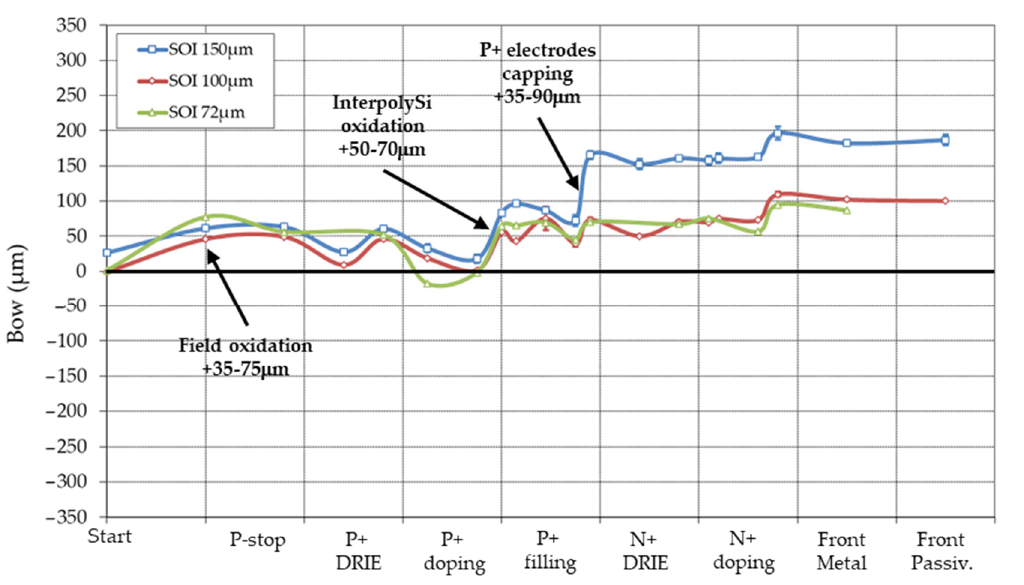
Figure 16. Bow variation during process of SOI wafers of various silicon device thicknesses. Handle wafer: 300 μ m, BOX: 1 μ m. Main stress contributors are indicated on the graph.